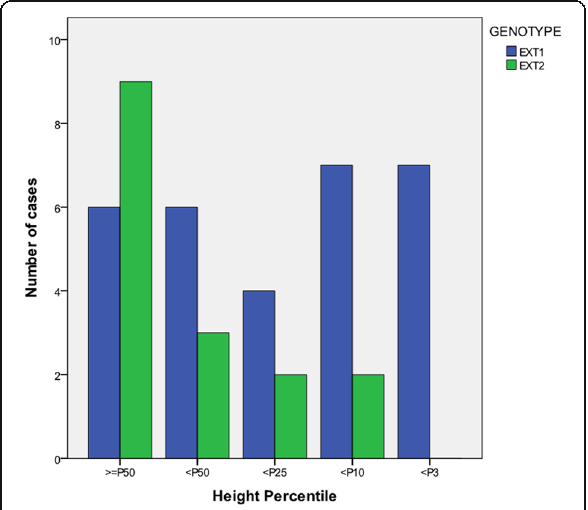
Fig. 2 Distribution of height percentile in EXT1 and EXT2 genotypes. The bar indicates the number of patients. Compared with EXT1 mutation patients, there were 9 of 16 patients (56.25%) with EXT2 mutations whose height was greater than the 50th percentile, whereas no patients ’ height fell below the 3rd percentile. ( p =